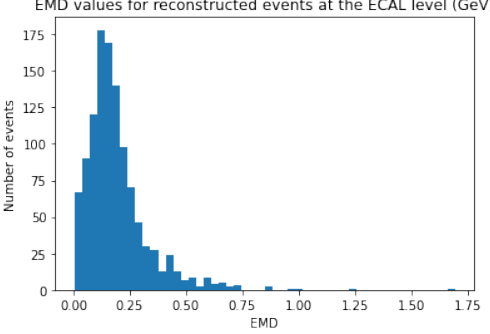
Figure 3. Original simulated top quark initiated jet (top) compared to the GVAE-reconstructed jet (bottom) in each of the three channels. The energy range is log-scaled for better visualization.